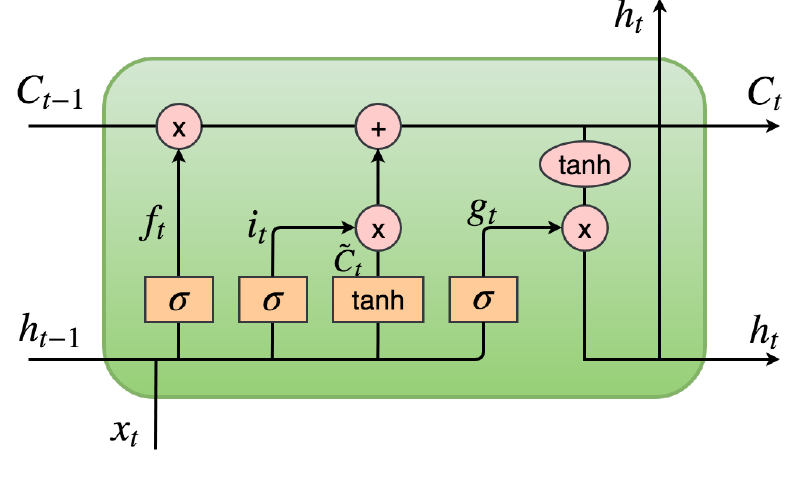
Figure 1. Structure of an LSTM